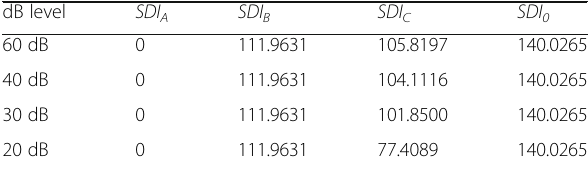
Table 5 SDI values during ABg fault at different